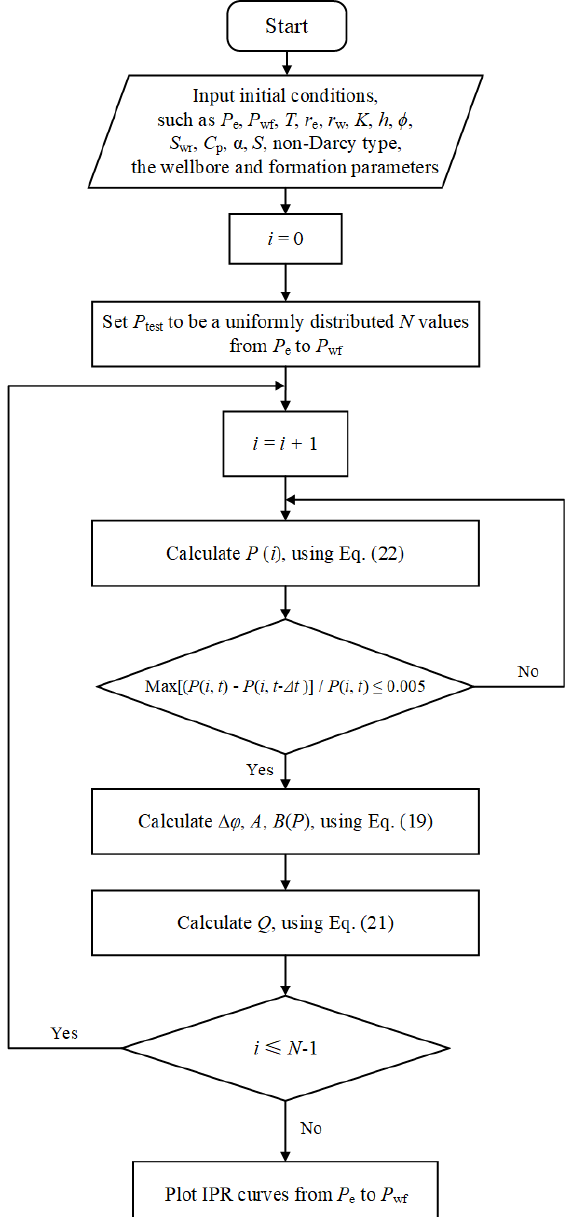
Figure 4. Calculation flow chart for gas reservoir pressure